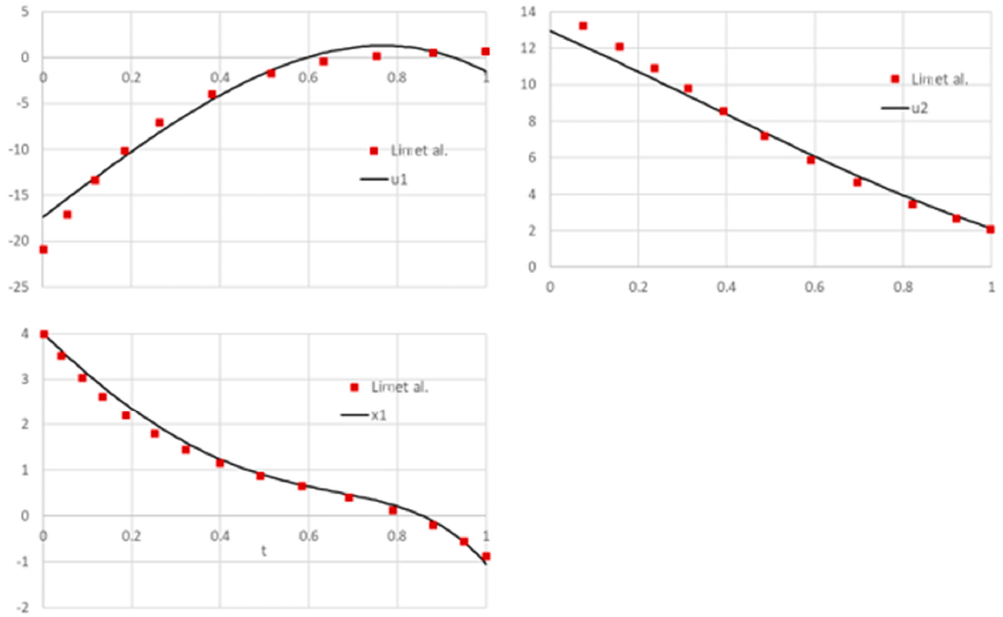
Figure 13. Direct comparison of spreadsheet solution with reported solution obtained by Lim et al. [20] for problem 3.2.